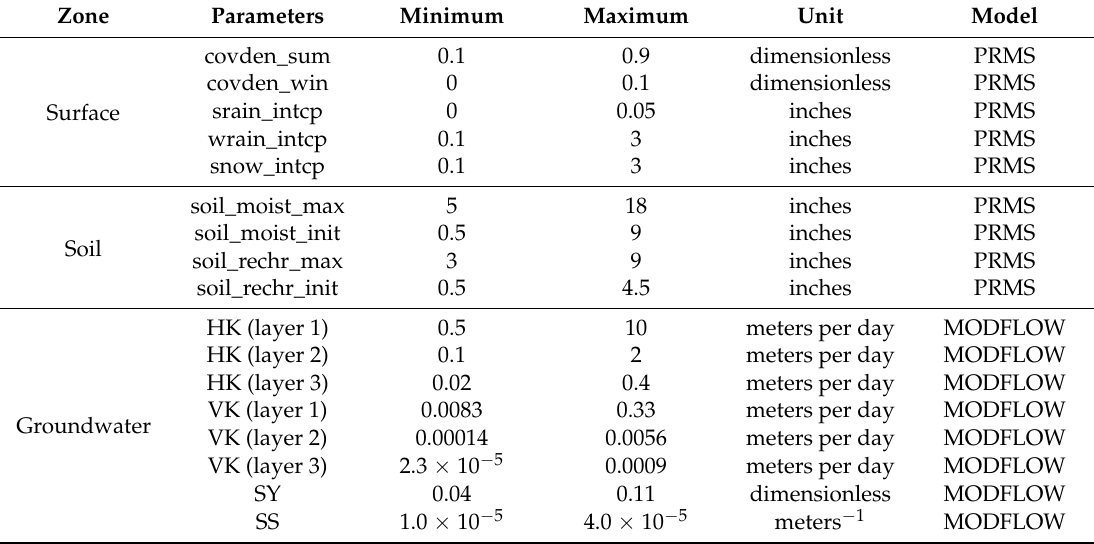
Table 1. Calibrated parameter ranges for the Miho GSFLOW